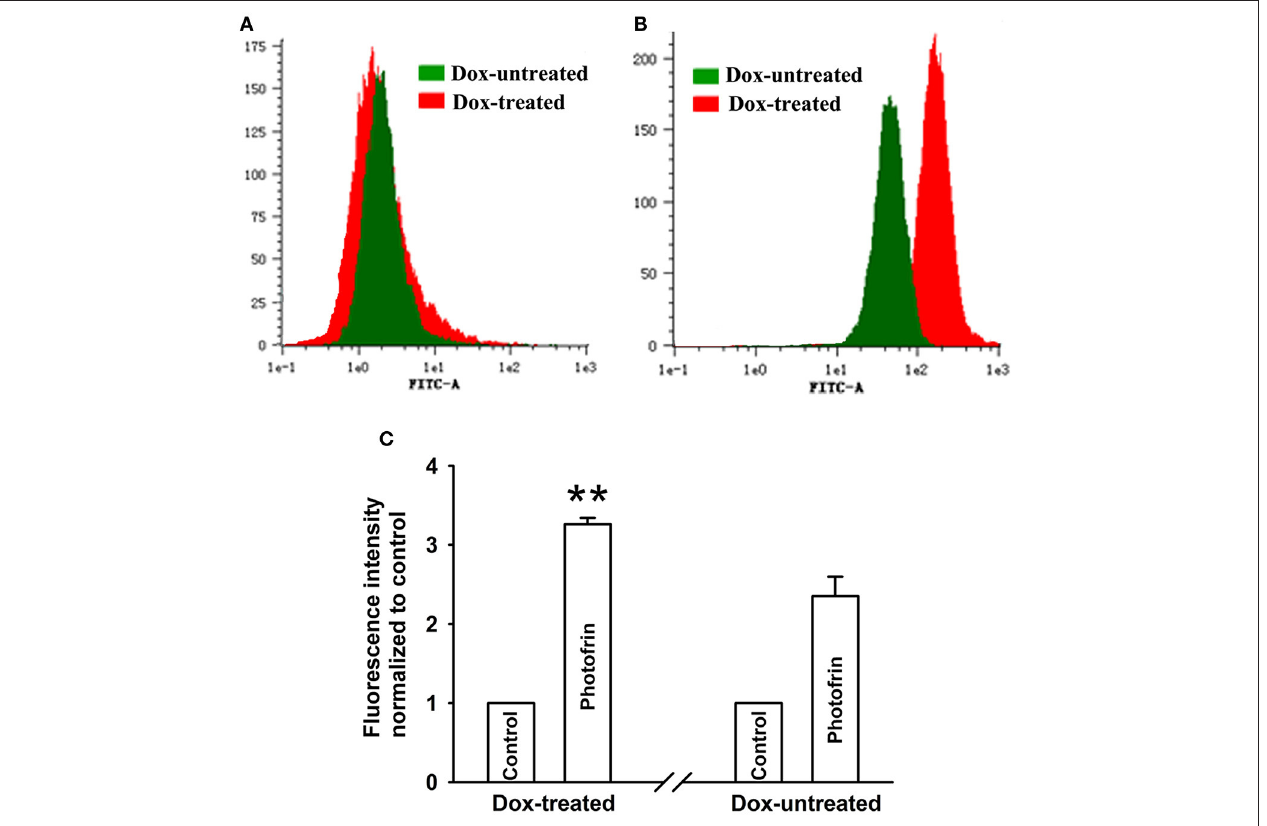
FIGURE 4 | Cx40-formed channels stimulate intracellular production of ROS. After incubation with DCFH-DA, Dox-treated and Dox-untreated cells were irradiated with or without Photofrin. Flow cytometry was performed to measure the fluorescence intensity of ROS 30min after PDT. (A) control; (B) 2.5 mg/mL Photofrin; (C) The fluorescence intensity of ROS. Data points are mean ± SD from 3 experiments. t- test was used to assess statistically significant differences between groups. ** P < 0.01, significantly different from Dox-untreated